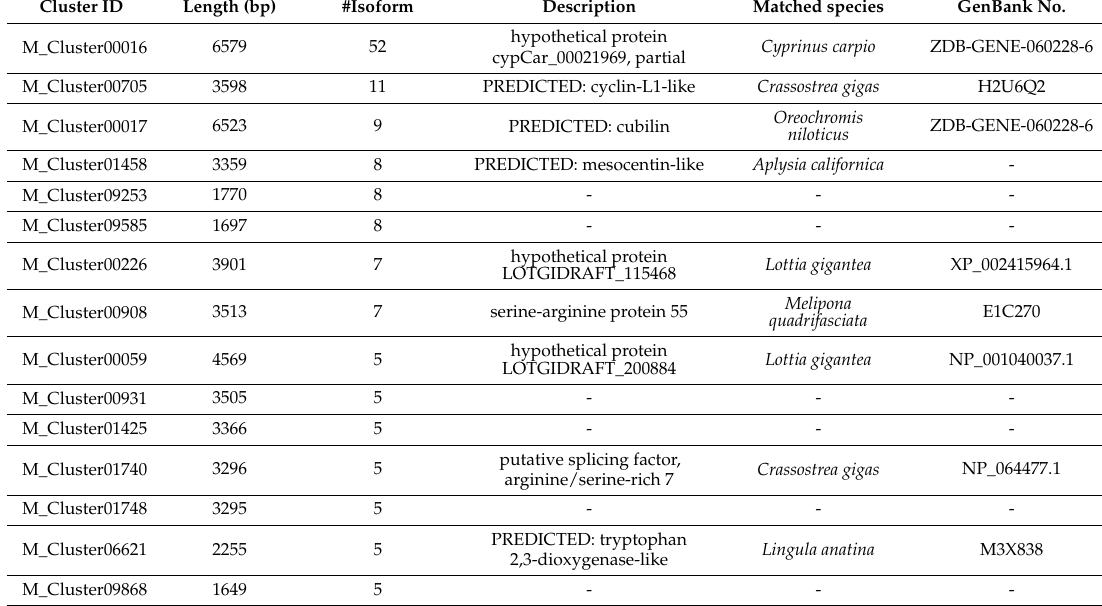
Table 5. List of top-ranked genes containing over five isoforms in the male